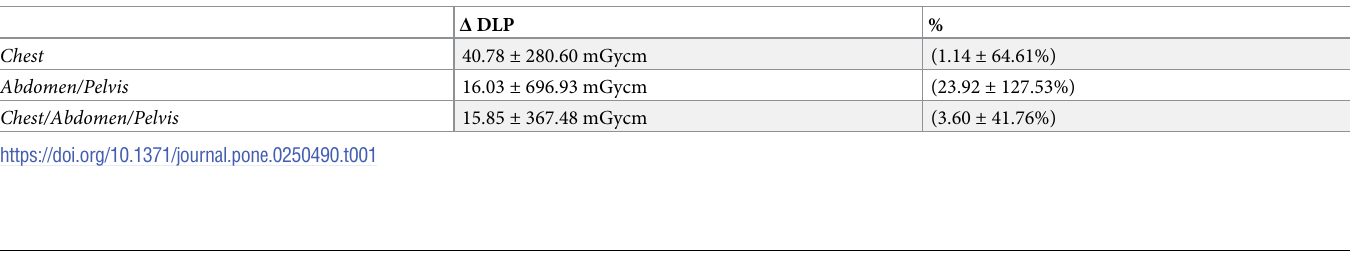
Table 1. Intraindividual DLP deviation in study population based on two consecutive staging CT examinations of the same body